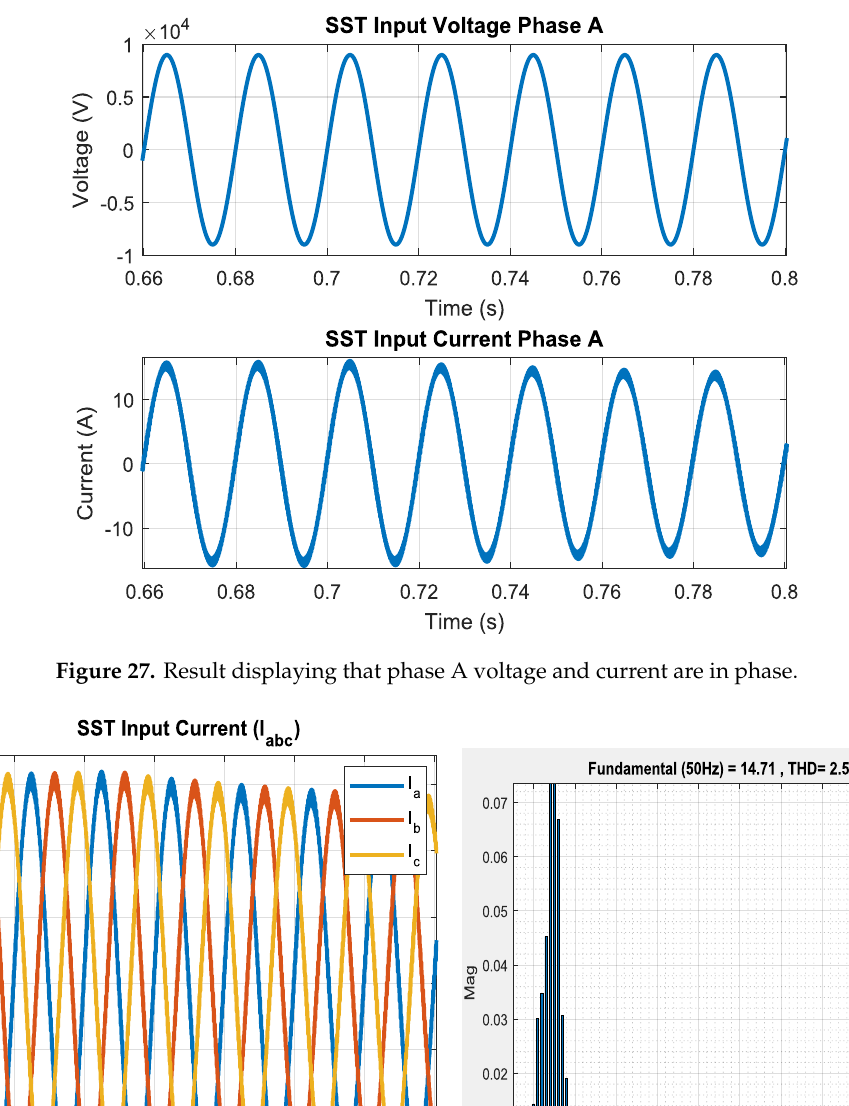
Figure 26. SST output current to the load. The figure is displaying the shift in phase of the current from the resistive load to inductive load at 0.7 s.